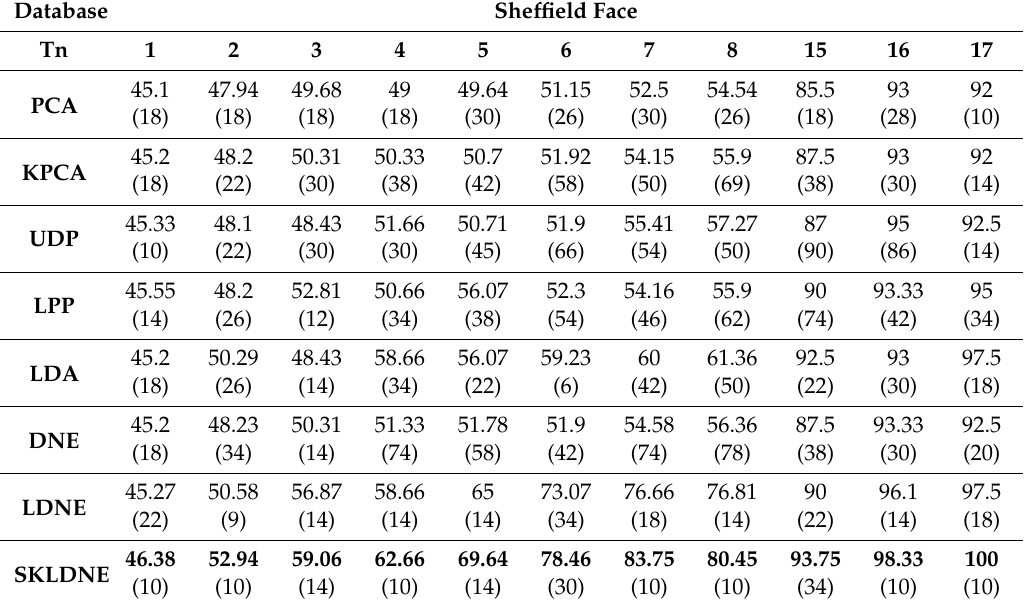
Table 1. Maximum recognition accuracies (in percentage terms) of supervised kernel locality-based discriminant neighborhood embedding (SKLDNE) and other methods for the different numbers of training and testing images on the Sheffield Face and corresponding dimensions (shown in